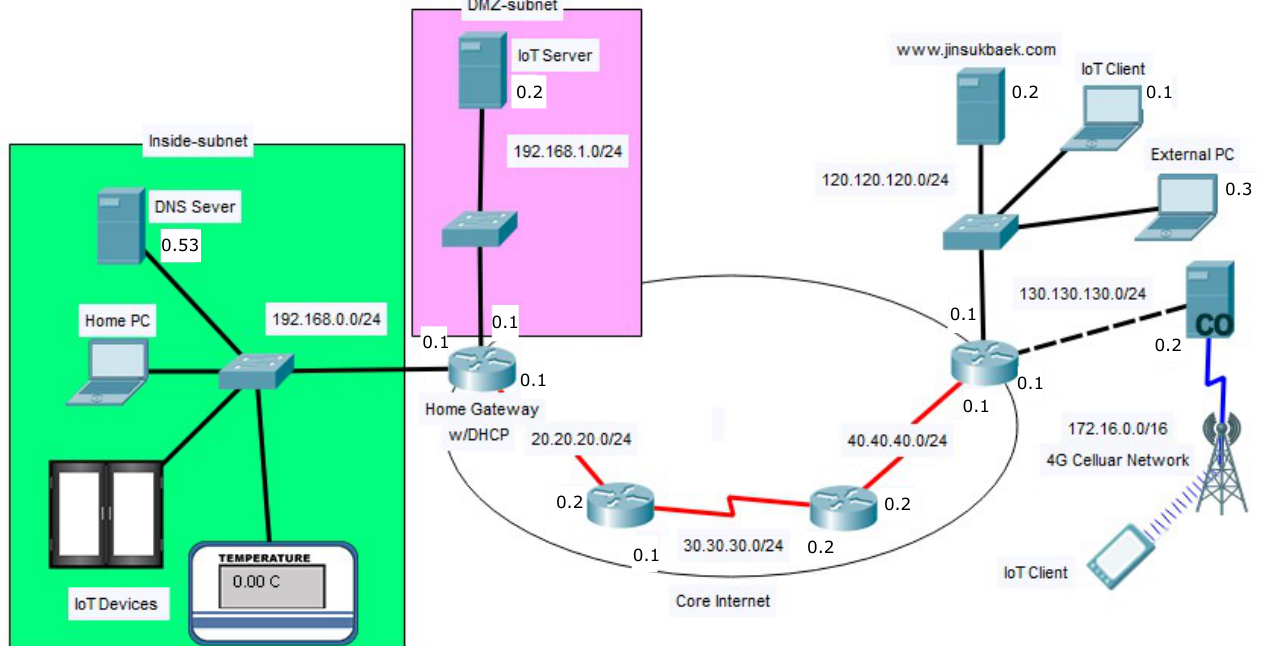
Figure 7. The overall network structure for our